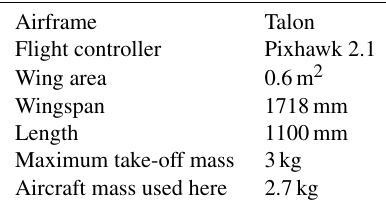
Table 1. Technical specification for the FMI-Talon